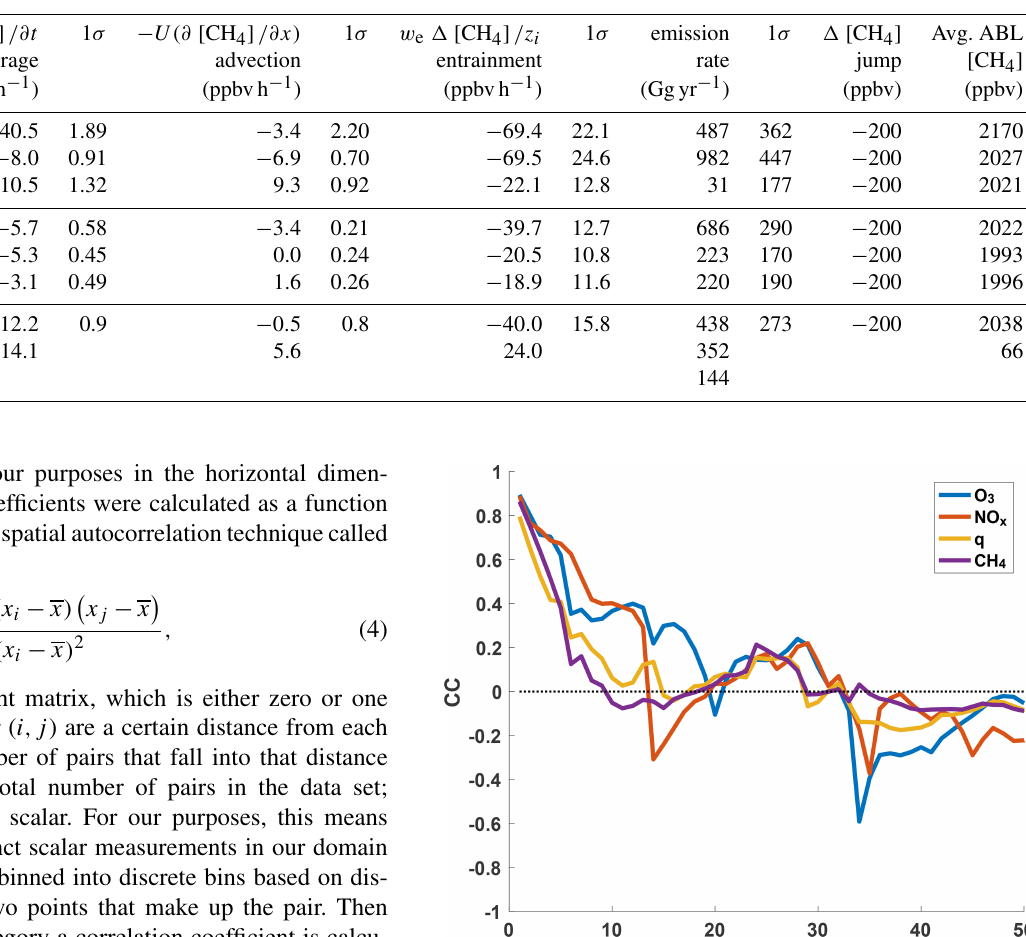
Table 3. CH 4 budgets for the six EPA flights. The columns labeled 1 σ represent the estimated error in the preceding term with the same units.